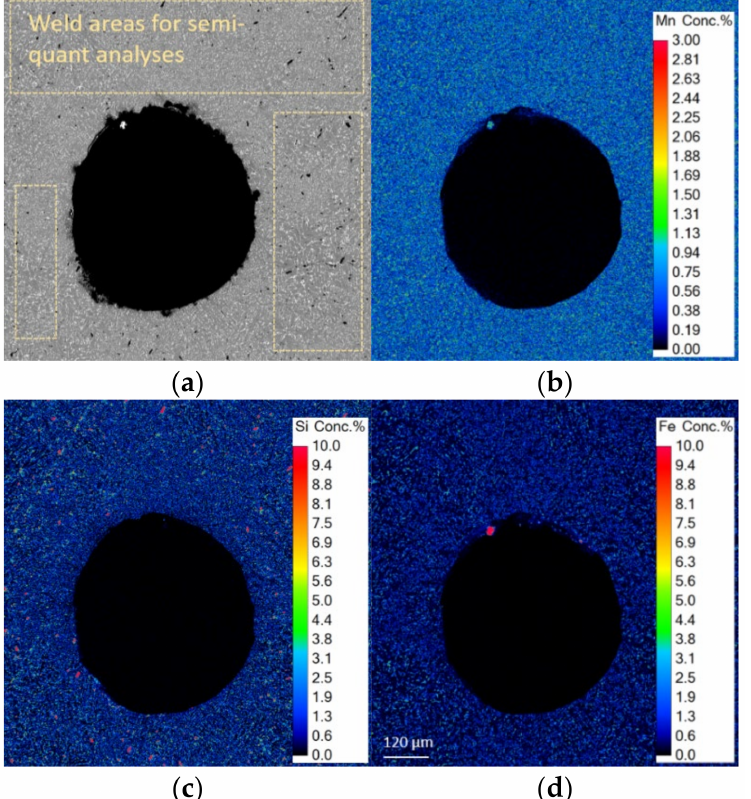
Figure A4. ( a ) BSE image showing a large pore (Ø ≈ 0.7 mm) in a weld. The integrated area of all three indicated yellow rectangles were used to semi-quantitively evaluated the elemental mappings for Al, Mg (both shown in Figure 8), ( b ) Mn, ( c ) Si and ( d )